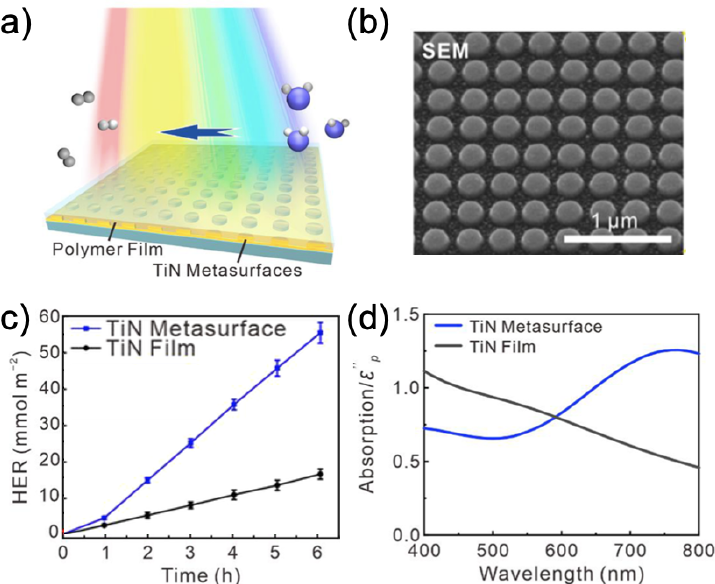
Figure 8. ( a ) Principle scheme of the hydrogen evolution induced by visible light by employing the TiN metasurface covered by the photocatalyst polymer. ( b ) SEM picture of the metasurface composed of TiN nanodisks. ( c ) HER rate of the photocatalyst polymer deposited on a TiN metasurface and TiN film (reference) versus time. ( d ) Calculated absorption spectra of the photocatalyst polymer deposited on the TiN metasurface and TiN film (reference). All the figures are reprinted (adapted) with permission from [91], Copyright 2021 American Chemical